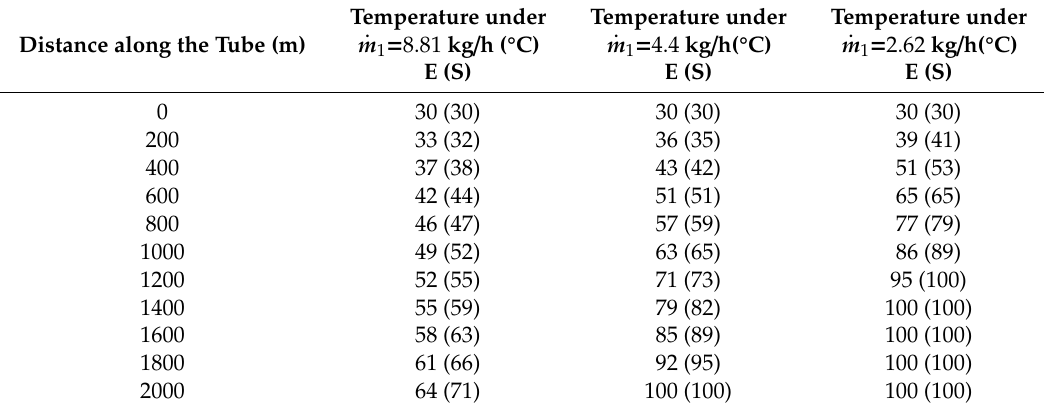
Table 2. Comparison of experimental (E) and simulated (S) water temperature along the tube.